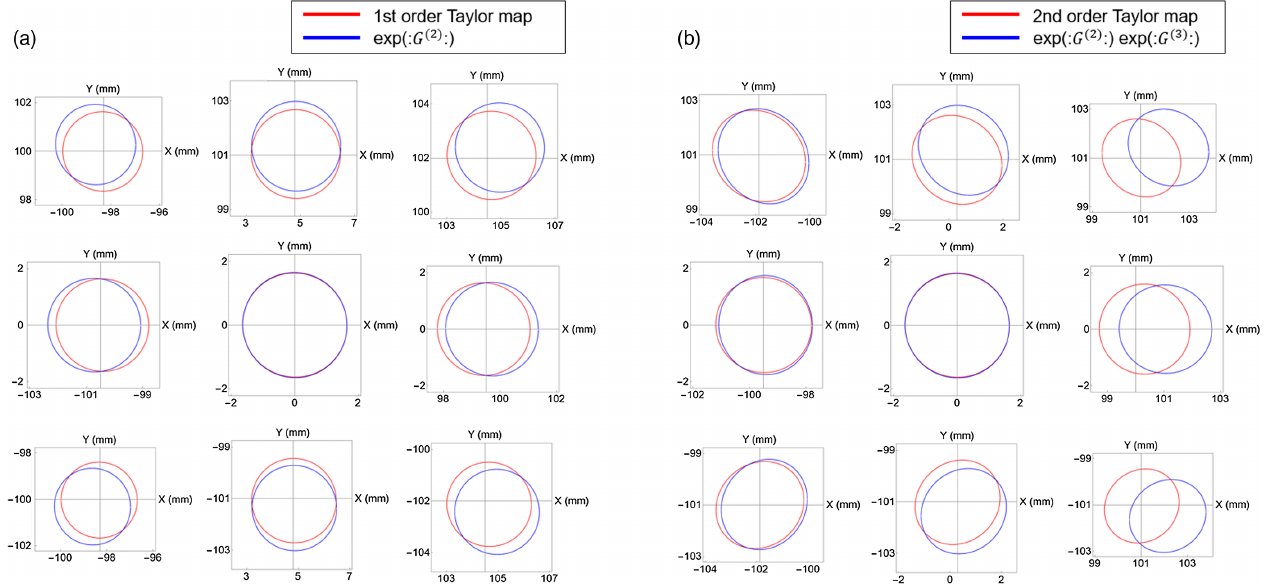
FIG. 13. 1 - σ beam ellipses at the eight edges and the center of the scanning area. Tracking results are drawn for first-order Taylor map and corresponding Lie map, exp ð ∶ G ð 2 Þ ∶ Þ (a), and second-order Taylor map and corresponding Lie map, exp ð ∶ G ð 2 Þ ∶ Þ exp ð ∶ G ð 3 Þ ∶ Þ (b).